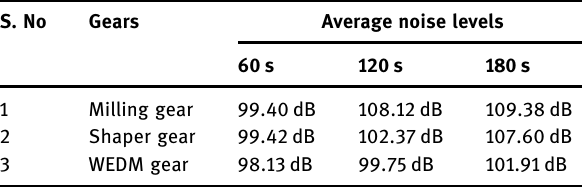
Table 3: Noise level results at di ff erent intervals of time S. No